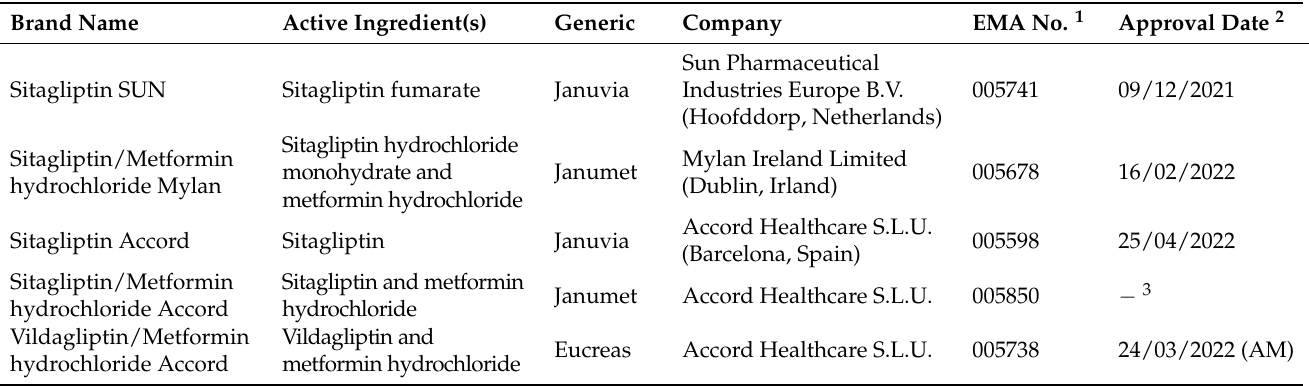
Table 3. European Medicines Agency (EMA)-approved generic medicines for DPP4